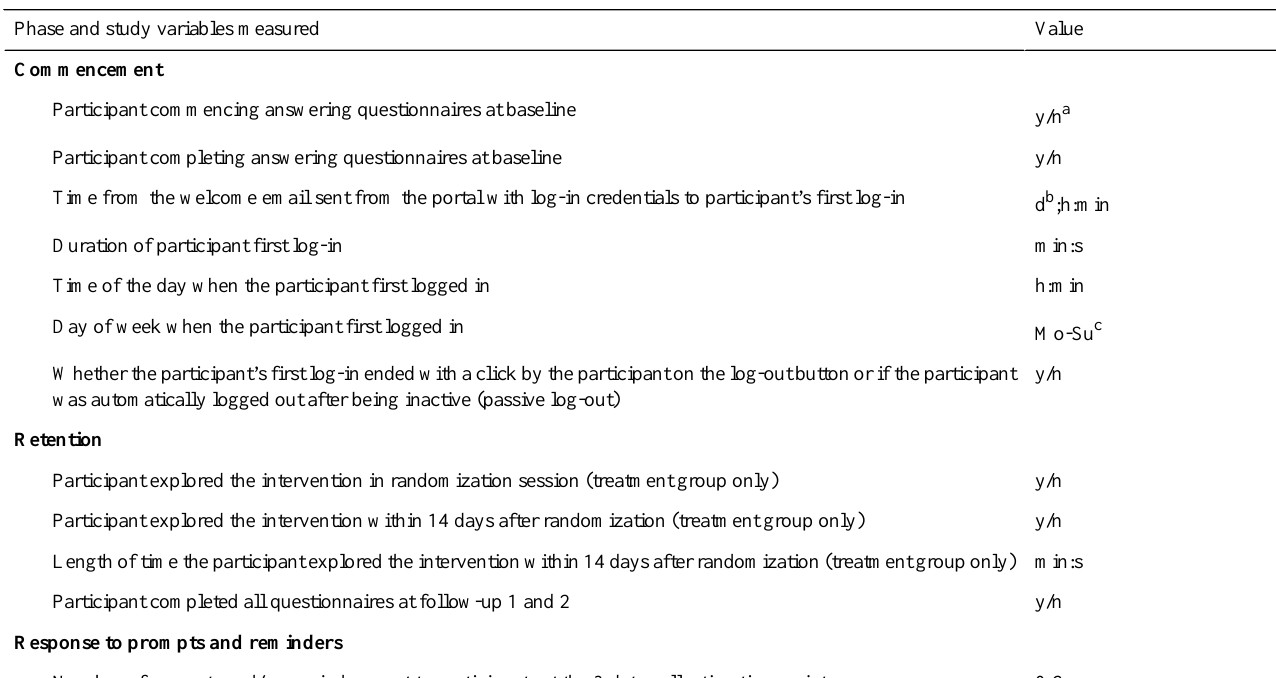
Table 2. Variables used in the